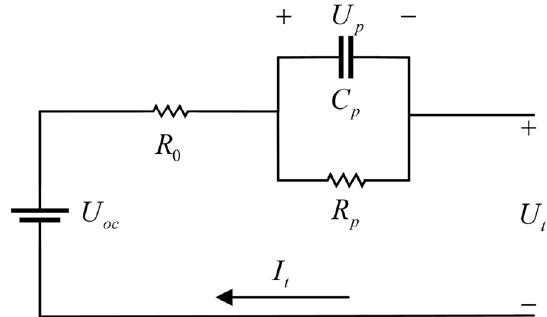
Figure 1 Circuit diagram of the Thevenin